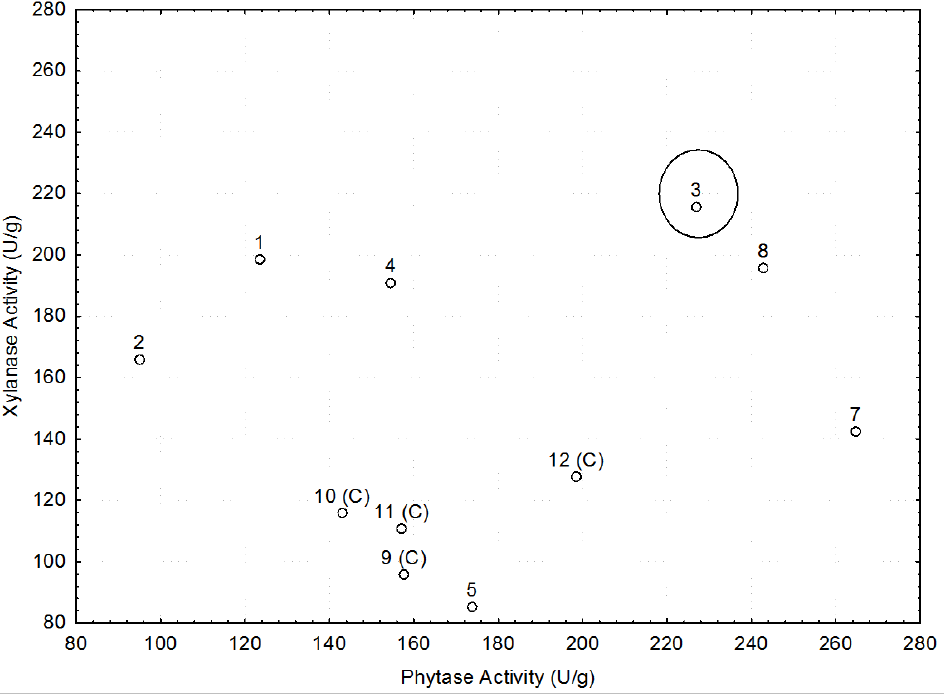
Figure 3. Simultaneous production of phytase and xylanase enzymes by